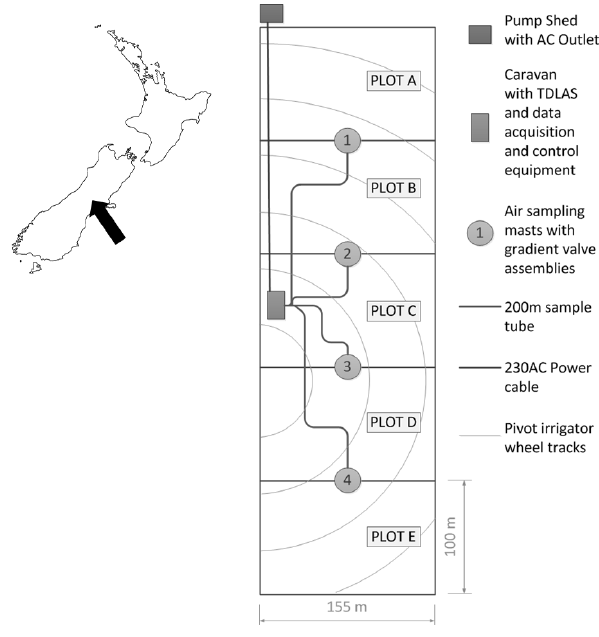
Fig. 1. Location of experimental site near Methven, Canterbury, New Zealand, where the FS-NOMAS was deployed (left panel). Field plan of sampling equipment showing field dimensions, lay- out of sampling masts relative to the TDLAS analyser and the AC power source (right panels). The gradient generated by the fluxes from each plot is measured by the most immediately adjacent and downwind mast. For example, fluxes from plot C are measured at mast 3 during a northerly wind and at mast 2 during a southerly